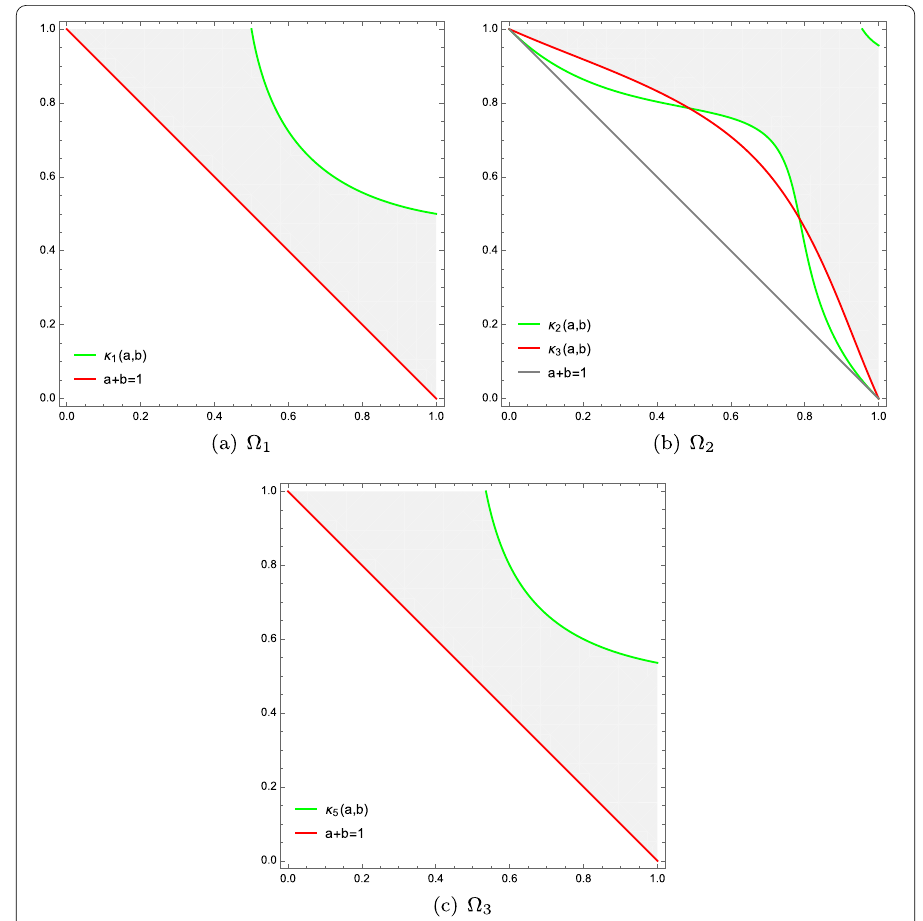
Figure 1 Visualized sub-regions Ω 1 , Ω 2 , and Ω 3 of { ( a , b ) ∈ R 2 | 0 < a , b < 1